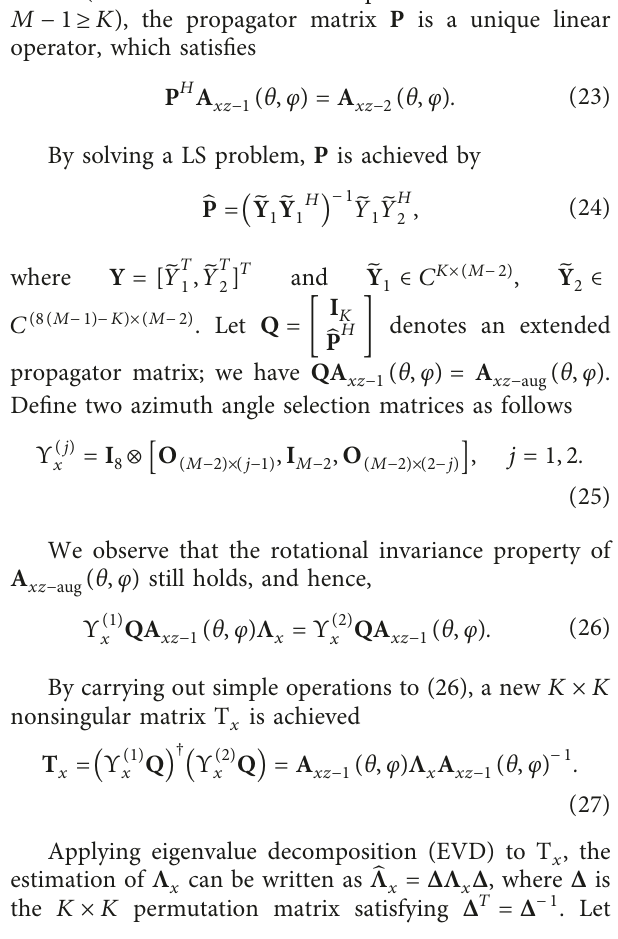
algorithm [12] (Section 3) to the generalized steering matrix (21). We can find propagator matrix by using PM, which ( θ , φ ) into two submatrices A partitions A xz − aug ( θ , φ ) of size K × K and ( 8 ( M − 1 ) − K ) × K , and A xz − 2